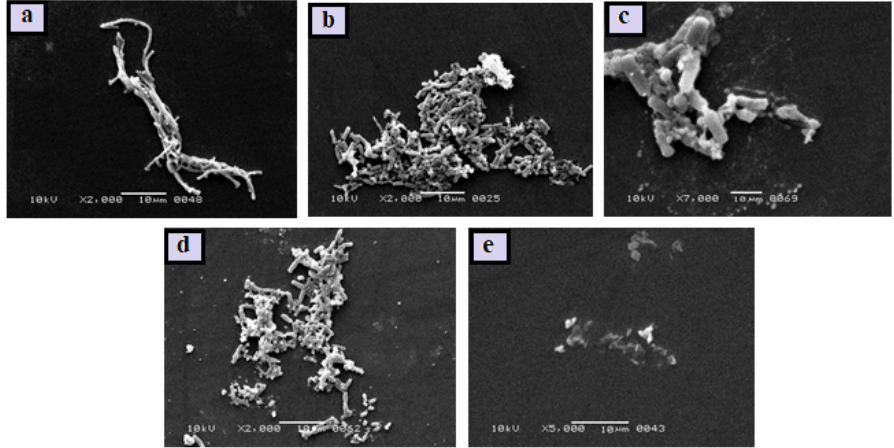
Figure 6. H. pylori control cells ( a ), H. pylori AMX treated ( b ), H. pylori Zn-MOF treated ( c ), H. pylori Am-Zn-MOF treated ( d ), and H. pylori L-Am-Zn-MOF treated ( e ).